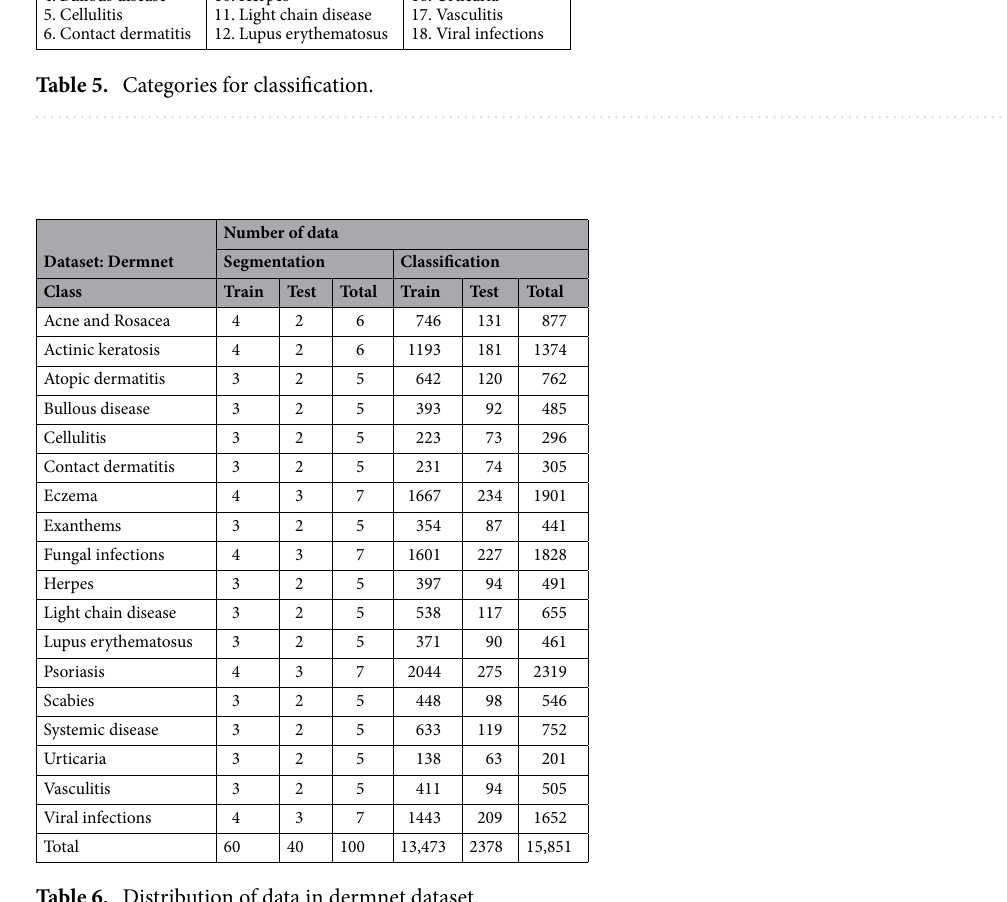
Table 6. Distribution of data in dermnet